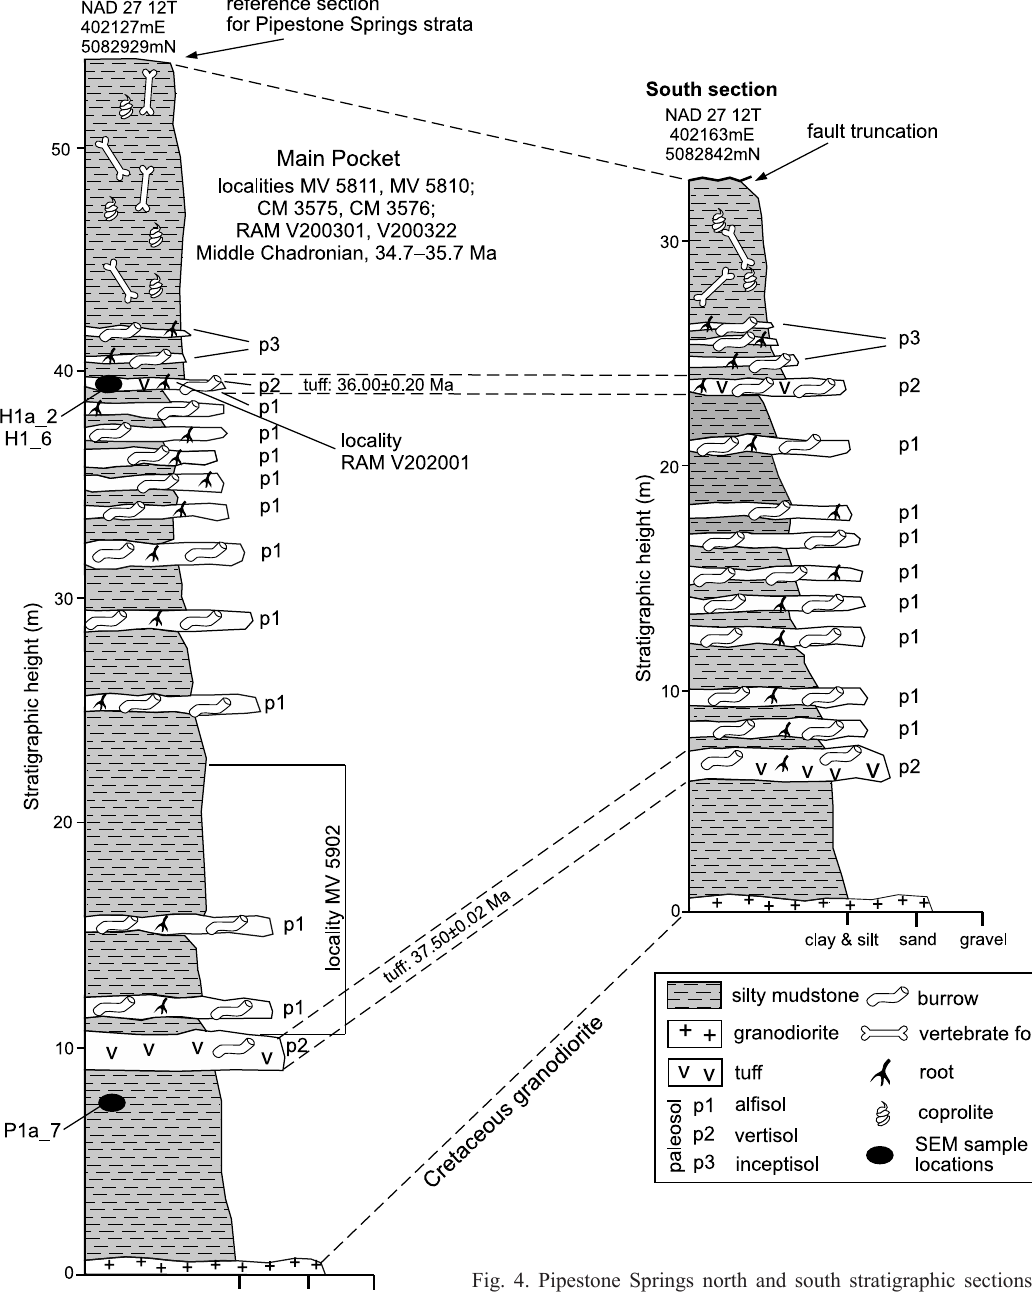
Fig. 4. Pipestone Springs north and south stratigraphic sections showing paleosols and SEM sample locations, with the north section specified as the reference